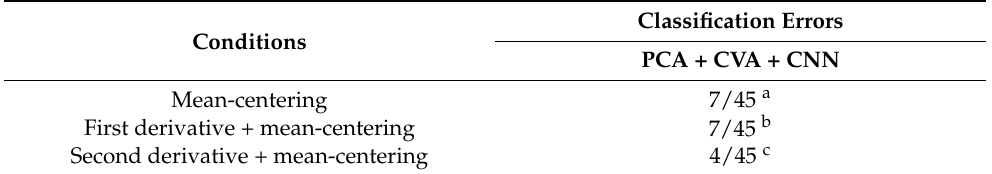
Table 7. Study #3: Prediction set classification errors (36 samples).